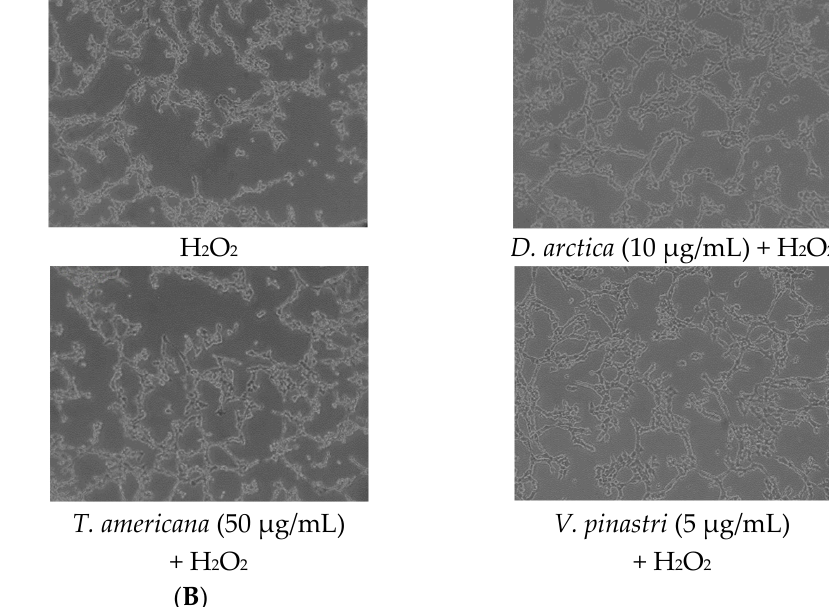
Figure 2. ( A ) Effect of methanol lichen extracts of cetrarioid clade on cytoprotection in stress oxidative models. SH-SY5Y cells were pretreated with non-cytotoxic concentrations of lichens for 24 h before H 2 O 2 (250 µM, 1 h). Cell viability was determined using MTT assay. Results were expressed as mean ± SD (triplicate experiments). * p < 0.01 versus control; # p < 0.01 versus H 2 O 2 . ( B ) SH-SY5Y cells morphology after treatments.